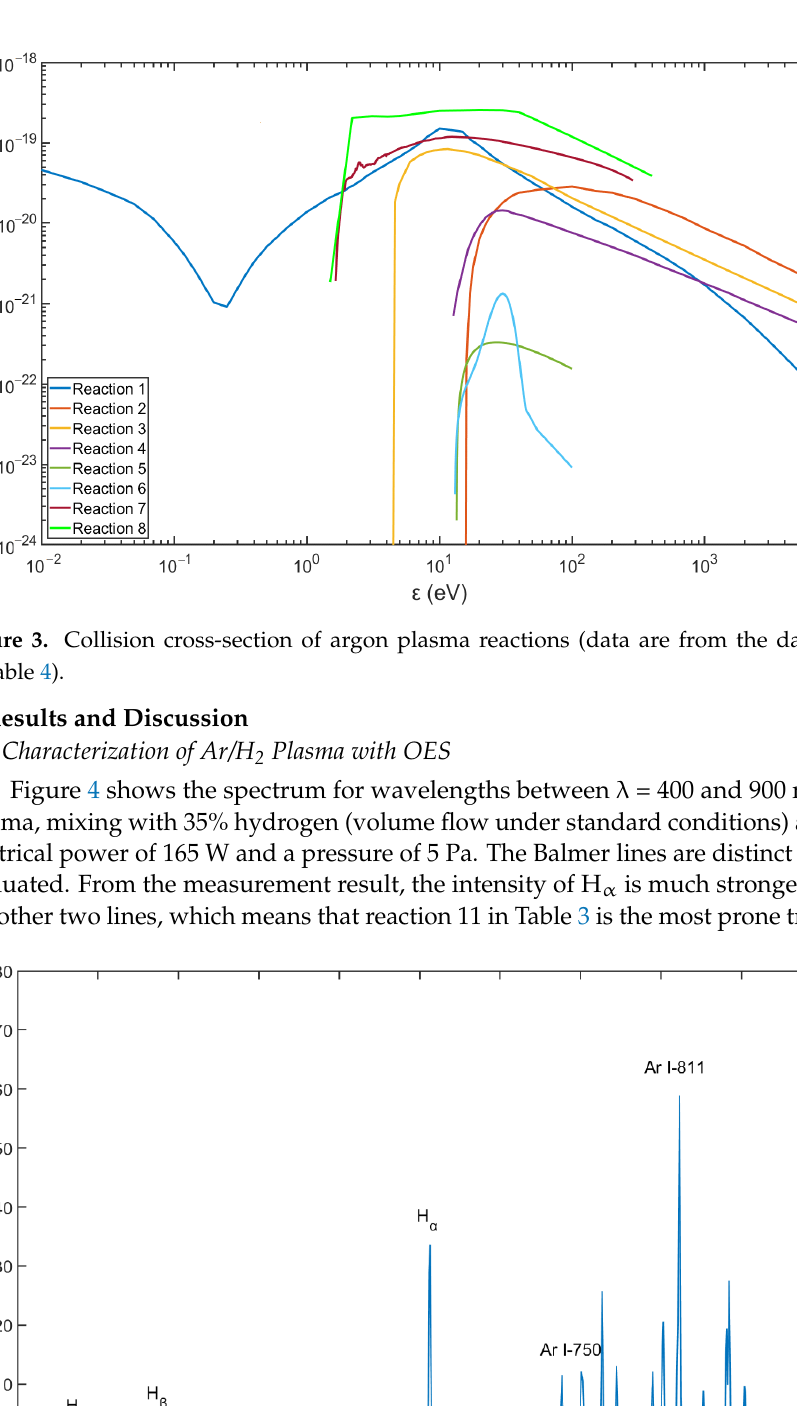
Figure 2. Collision cross-section of hydrogen plasma reactions (data are from the databases listed in Table 3).